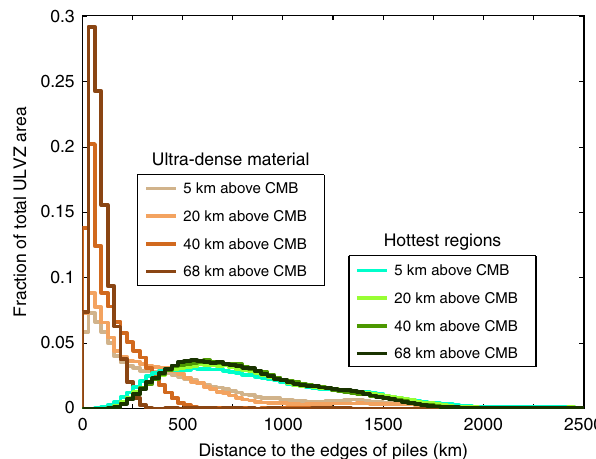
Fig. 2 Distance of ULVZs from thermochemical pile edges. For each distance in the horizontal axis, the corresponding vertical axis shows the areal fraction of hottest regions or accumulations of ultradense material at this distance. Here, the hottest regions refer to candidate regions for melting (e.g., Fig. 1b – e), the regions with accumulations of ultradense material refer to places where the effective buoyancy ratio ( B eff ) is larger than 1.5, and the edges of piles are identi fi ed at locations with B eff = 0.1. The distances are calculated at 4 depths of 5, 20, 40km and 68 km above the (Supplementary Movie 1). We compute the lateral distance of hottest regions from the closest edges of thermochemical piles throughout the model run. We exclude the hottest regions that are within 500 km from side boundaries of the model domain.